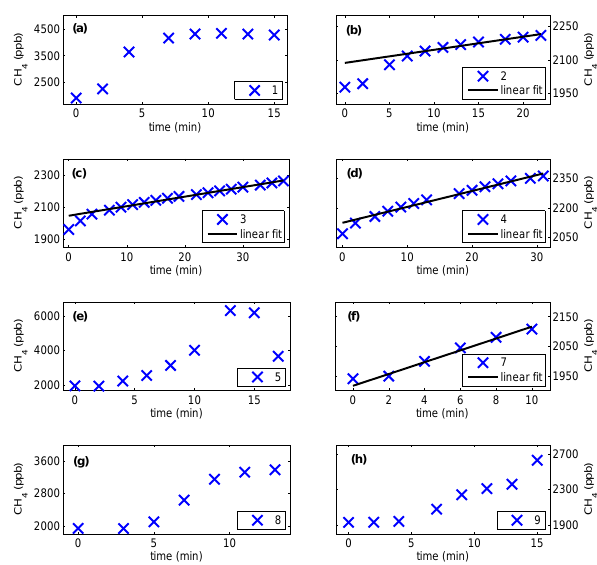
Figure 6. Floating chamber experiments conducted on the clarifica- tion basin when the mixer was off (a–d) and on (e–h) , respectively.